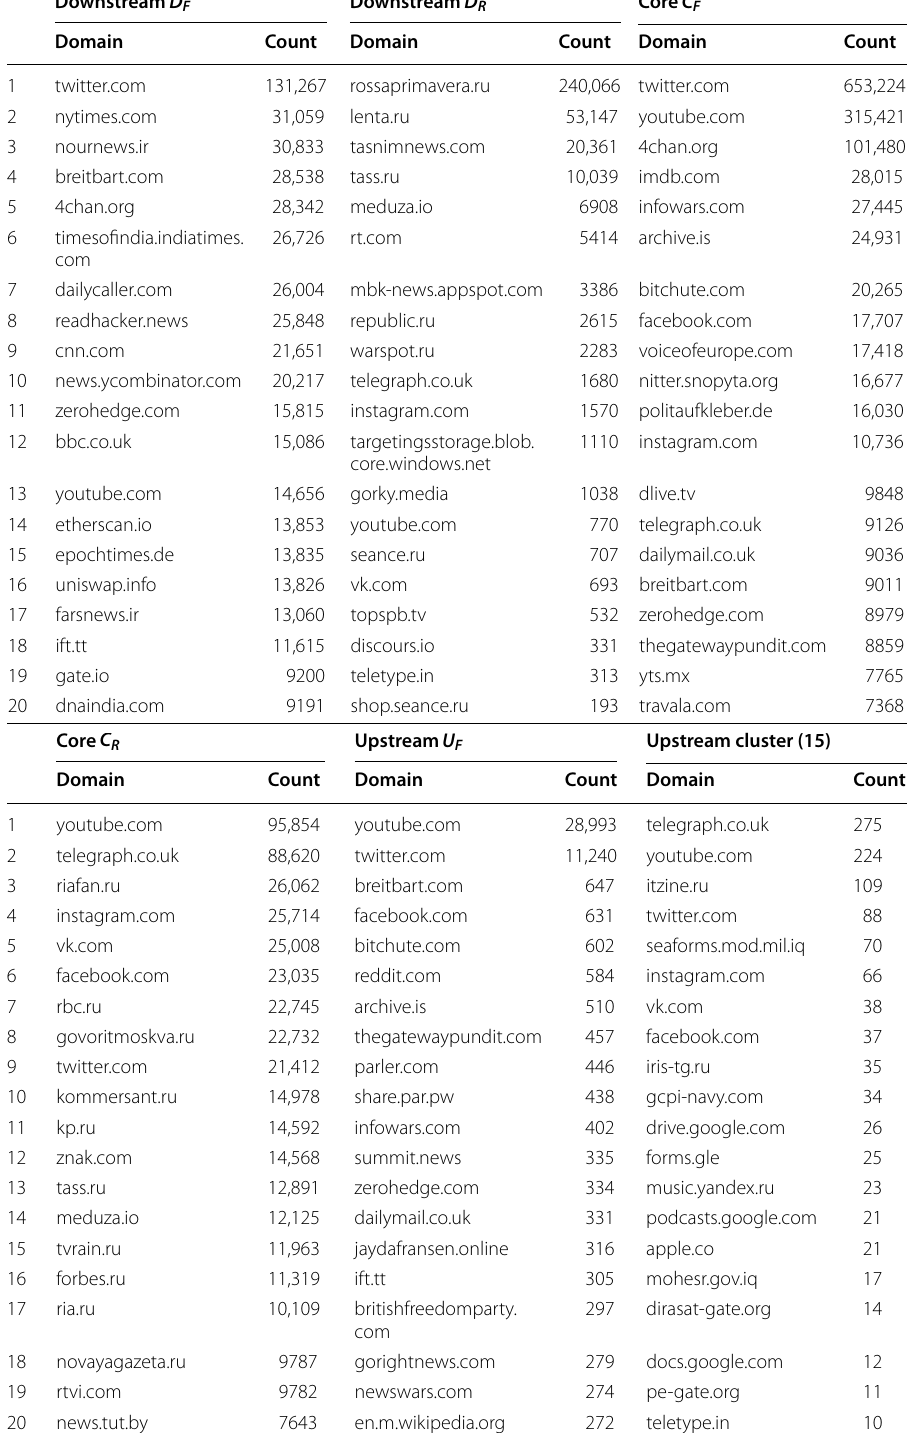
Table 8 Top URL domains shared in the main communities of the network G 3 (March 2020 to Dec. 2020, Fig.